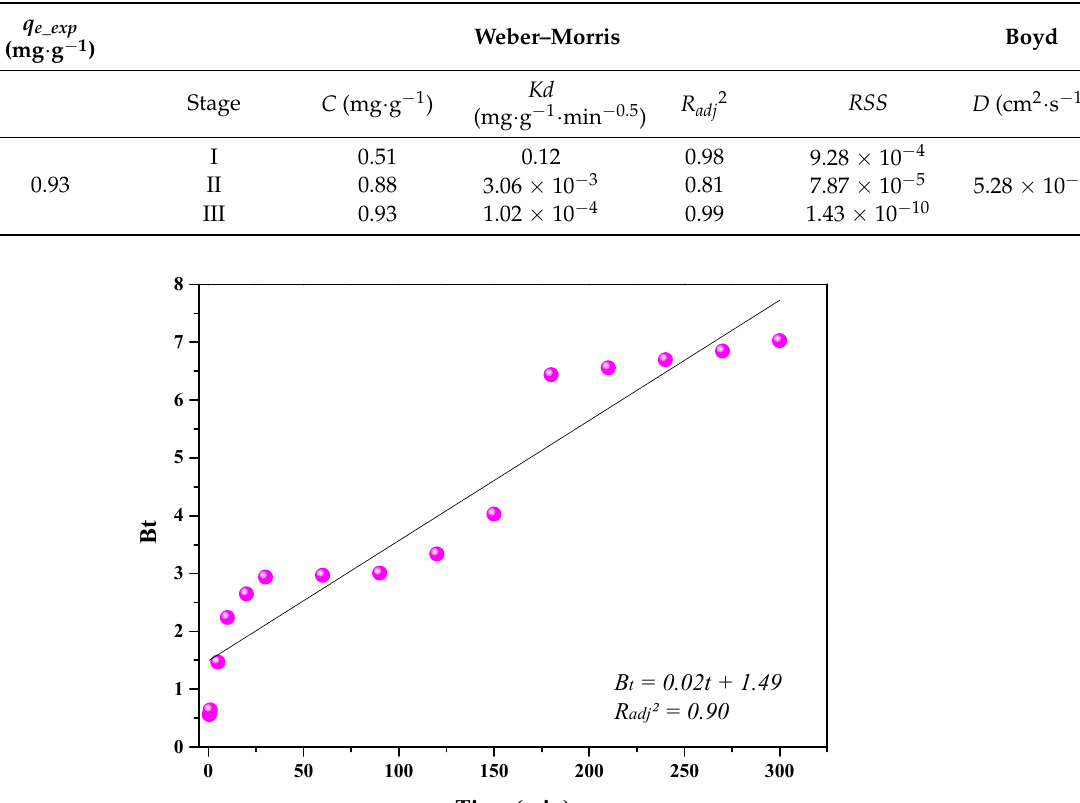
Figure 8. Boyd diffusion model observed for the treatment of 10 mg.L − 1 MR with 10 g.L − 1 CaSF at 20 °C, stirring the system at 100 rpm.